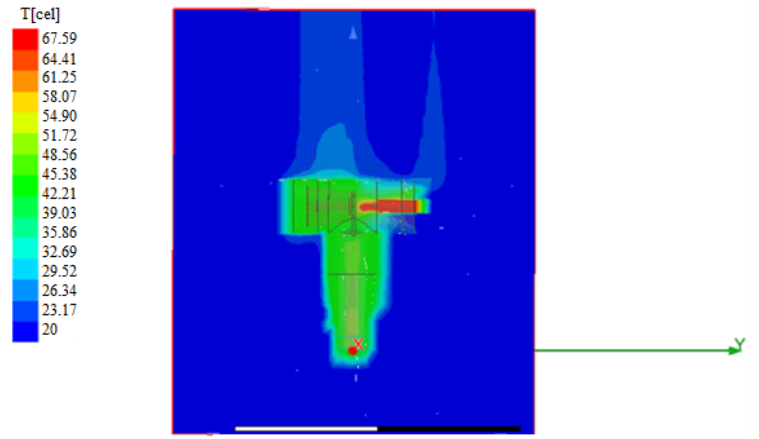
Figure 8. Temperature flow in a connector head, I = 630 A for an ambient temperature of 20